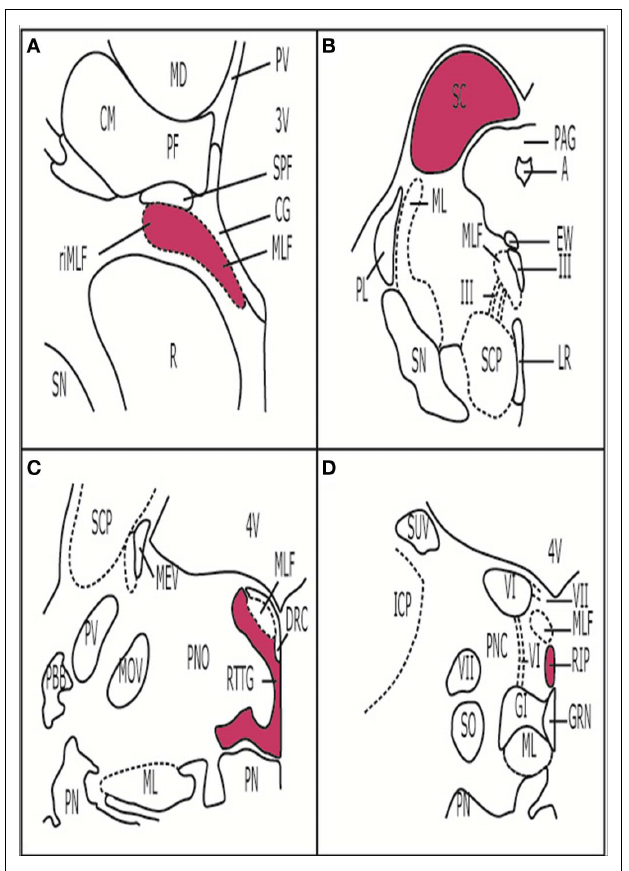
FIGURE 4 | Premotor oculomotor nuclei. (A) Brain stem scheme of a frontal section cut perpendicular to the intercommissural axis of Forel showing the rostral midbrain.The Rostral interstitial nucleus of the medial longitudinal fascicle is part of the premotor oculomotor system.These cells, which are embedded in MLF showTDP-43 inclusions in FTLD–TDP cases. (B) Brain stem scheme of a horizontal section through the caudal midbrain with the superior colliculus (SC).TDP-43 inclusions were found in the SC in all the cases examined. (C) Brain stem scheme of a horizontal section through the mid-level of the pons with the reticulotegmental nucleus of the pons (RTTG; nucleus Bechterew) and the medial longitudinal fascicle ( MLF ). (D) Brain stem scheme of a horizontal section through the caudal pons with the raphe interpositus nucleus (RIP), and the MLF . Abbreviations: A, aqueduct; CG, central gray; CM, centromedian nucleus of the thalamic central complex; DRC, dorsal raphe nucleus, caudal part; EW, Edinger-Westphal nucleus; GI, gigantocellular reticular nucleus; GRN, great raphe nucleus; ICP , inferior cerebellar peduncle; LR, linear raphe nucleus; MD, mediodorsal nucleus of the thalamus; MEV , mesencephalic trigeminal tract; ML , medial lemniscus; MLF , medial longitudinal fascicle; MOV, motor trigeminal nucleus; PAG, periaqueductal gray; PBB, pontobulbar body; PF, parafascicular nucleus of the thalamic central complex; PL, paralemniscal nucleus; PN, pontine nuclei; PNC, pontine reticular formation, caudal nucleus; PNO, pontine reticular formation, oral nucleus; PV, paraventricular nuclei of the thalamus; R, red nucleus; RIP, raphe interpositus nucleus; ri MLF, rostral interstitial nucleus of the medial longitudinal fascicle; RTTG, reticulotegmental nucleus of the pons (nucleus Bechterew); SC, superior colliculus; SCP , superior cerebellar peduncle; SN, substantia nigra; SO, superior olive; SCP , superior cerebellar peduncle; SPF, subparafascicular nucleus of the thalamic central complex; SUV, superior vestibular nucleus; III, oculomotor nucleus; III , oculomotor nerve;VI, abducens nucleus; VI , abducens nerve;VII, facial nucleus; VII , facial nerve 3V, third ventricle; 4V, fourth